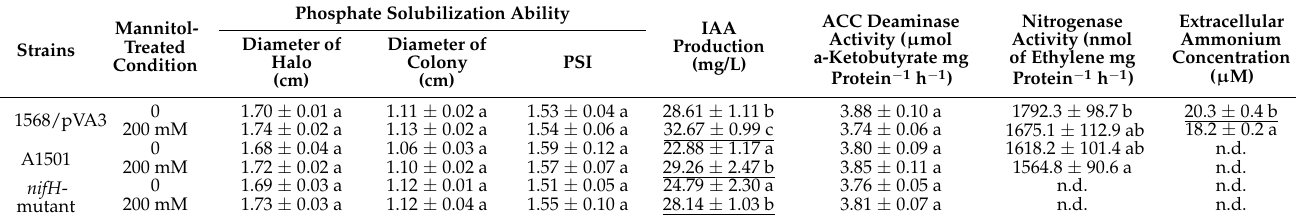
activity decreased by 3.4% for A1501 (1564.8 nmol of ethylene mg protein − 1 h − 1 ) and 7.0% for 1568/pVA3 (1675.1 nmol of ethylene mg protein − 1 h − 1 ) in the presence of mannitol. As expected, the nifH mutant strain 1502 failed to fix nitrogen in all treatments (Table 1).